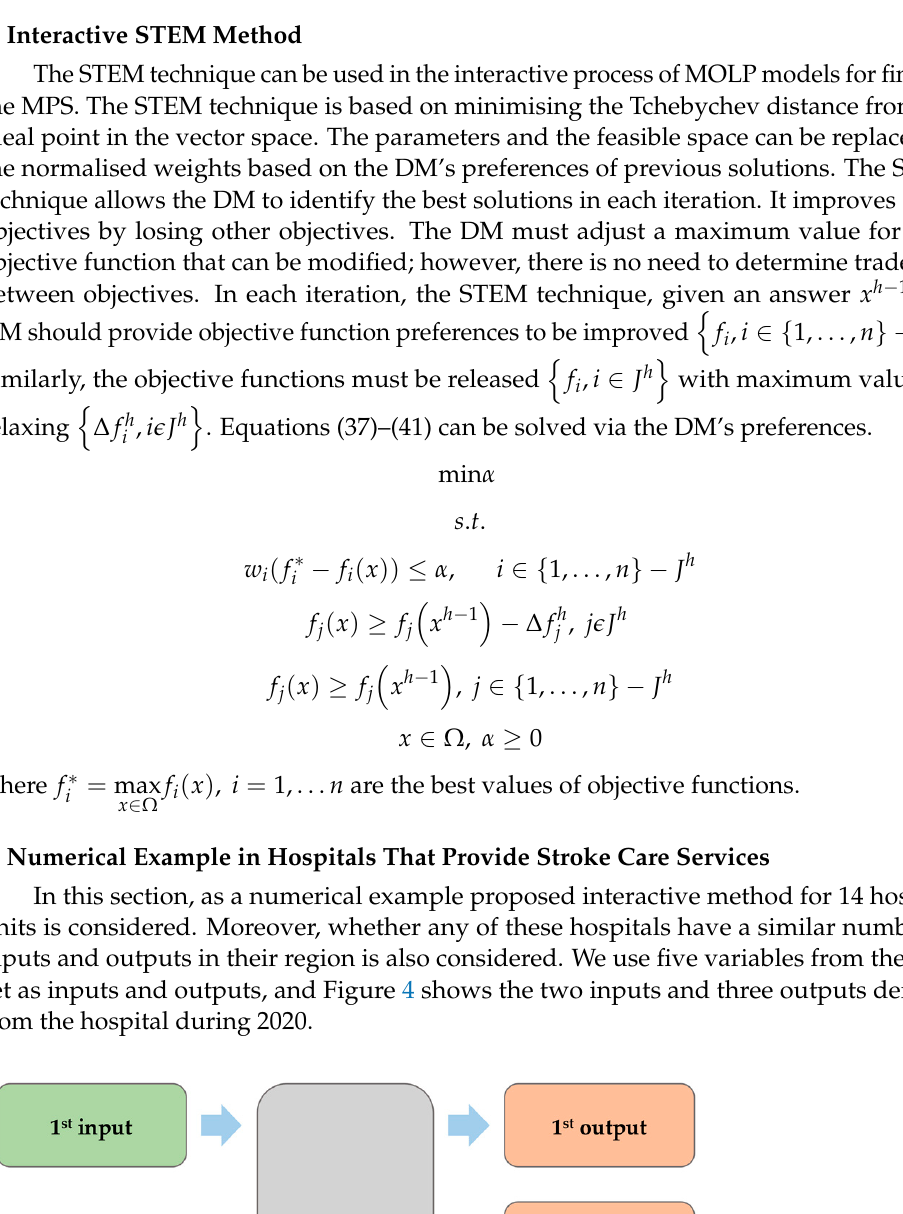
Table 1. The description of inputs and outputs in hospitals.